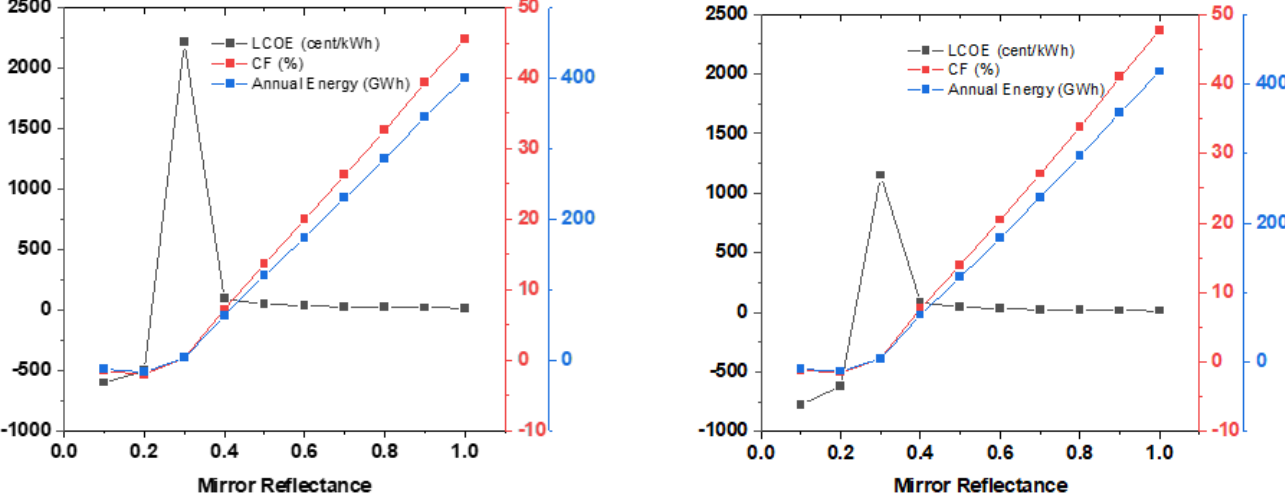
Figure 9. Effect of mirror reflectance on some metrics for SCO 2 power cycle with HTF A ( left ) and HTF B ( right ).